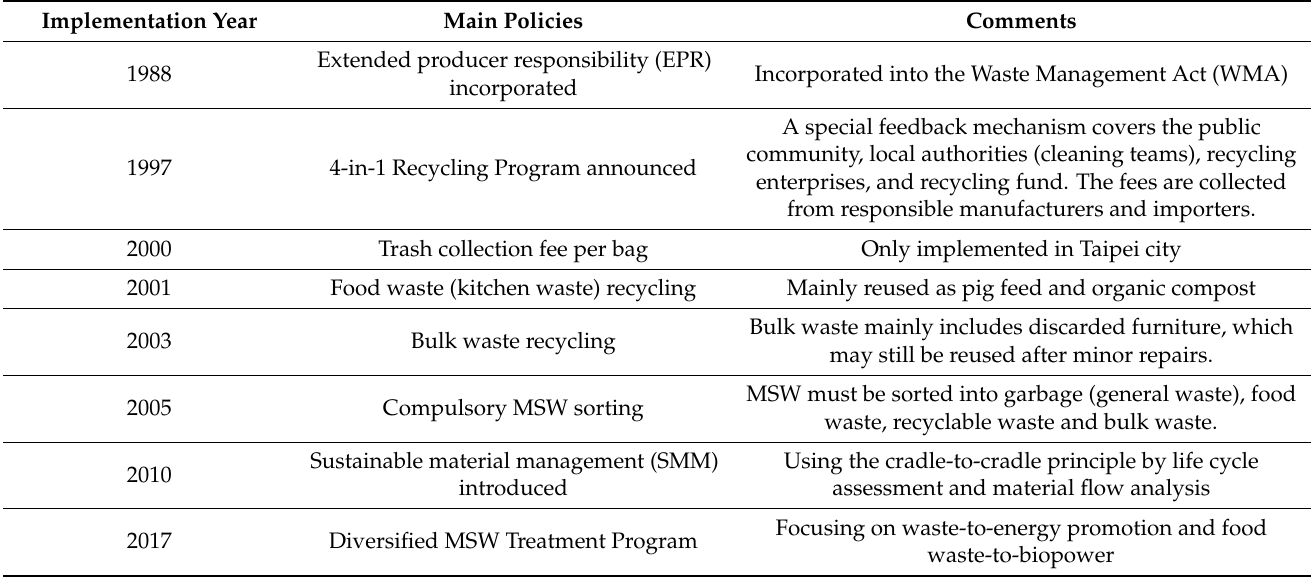
Table 1. Main policies for recycling resources from municipal solid waste (MSW) in